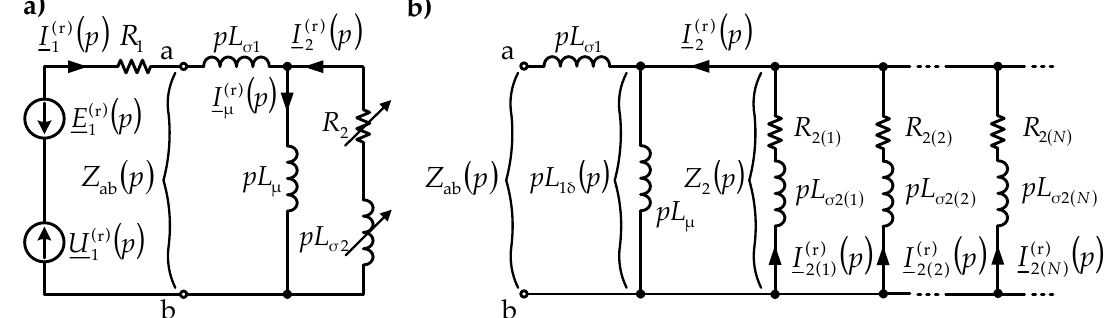
Figure 1. The IM equivalent circuits expressed in the Laplace-domain: ( a ) the IM equivalent circuit with rotor resistance and leakage inductance modelled by parameters varying as a function of slip frequency, ( b ) the approximation of the rotor electromagnetic parameter variability by the parallel connected two-terminal network in the rotor equivalent cir- cuit.